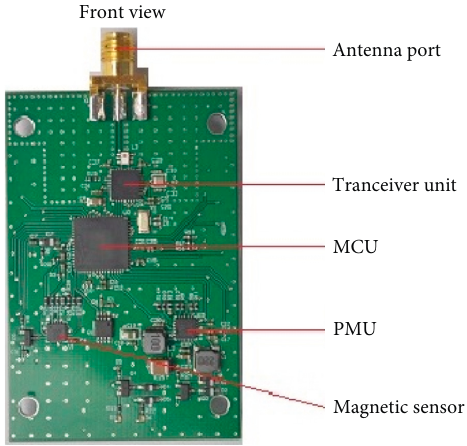
Figure 1: KiliNode top view showing various hardware components.